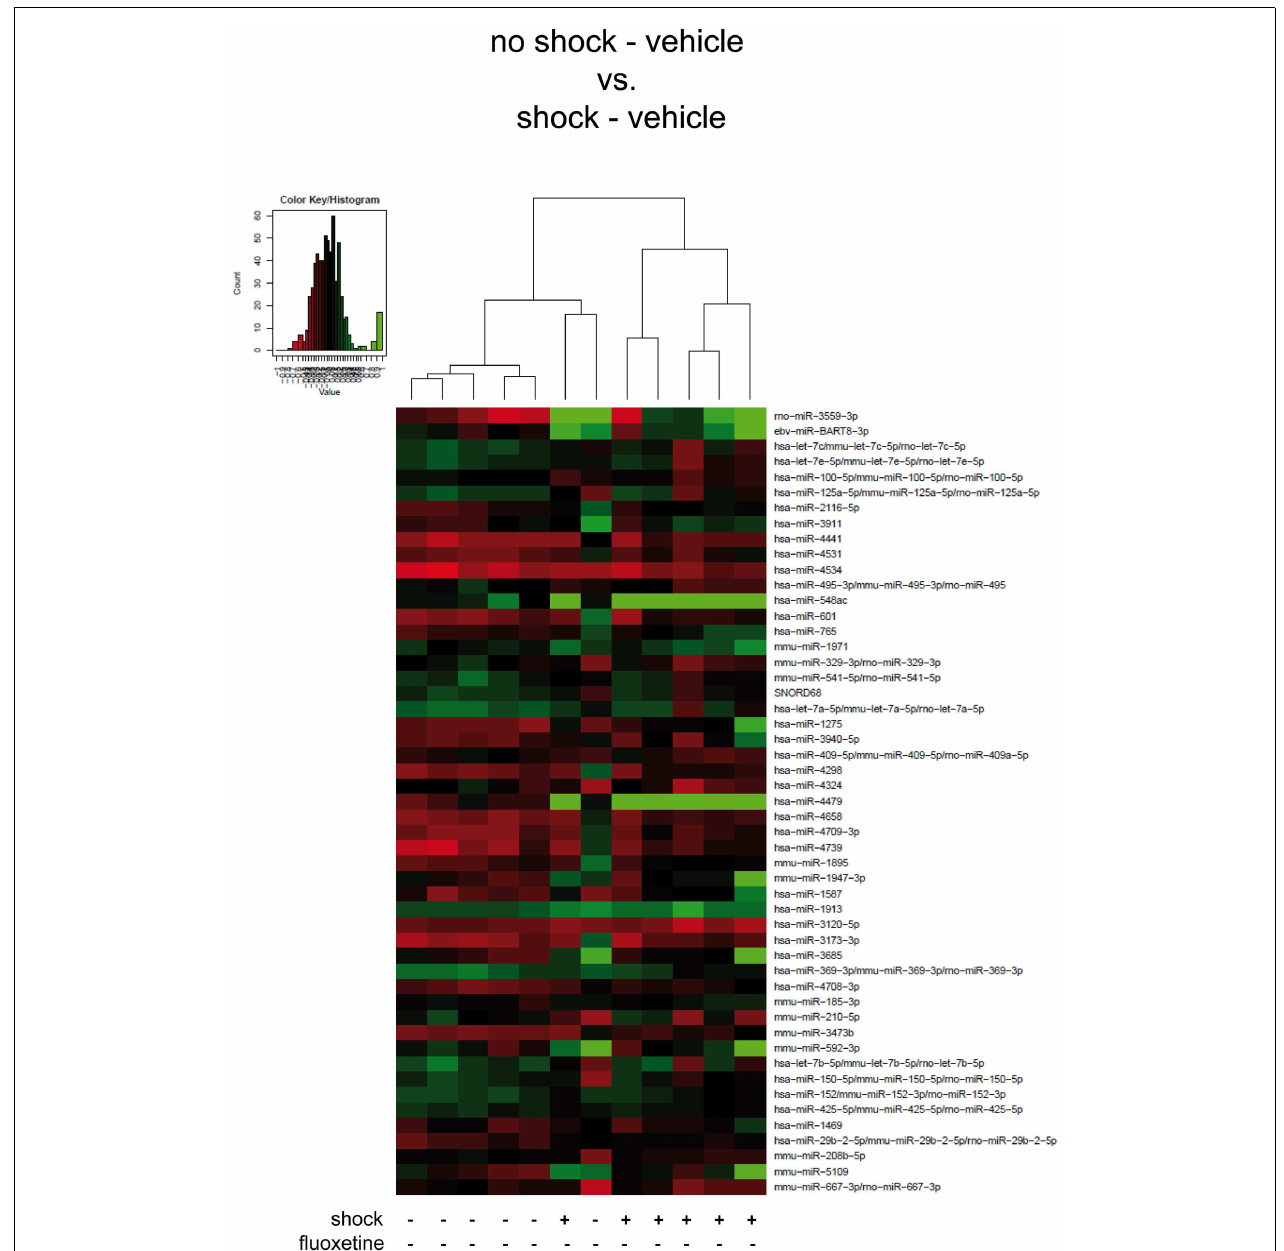
(“shock”) or mock treatment (“no-shock”) from male C57/BL6/N mice ( n = 6 per group). Each row represents a miRNA and each column represents a sample. Dendrograms represent complete-linkage clustering (by Euclidean distance) between samples.The sample clustering tree is shown on the top.The color scale illustrates the intensities of the relative miRNA expression levels: decreased scores are represented in red and increased in green, with intensity encoding magnitude. See Section “Materials and Methods” for statistical procedures.Vehicle, drinking water (solvent of fluoxetine).